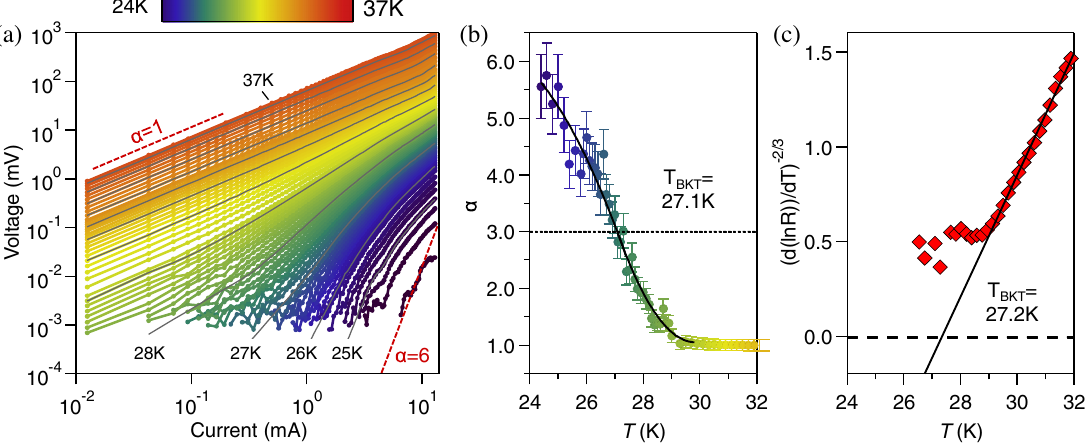
FIG. 3. In situ V ð I Þ characteristics and R ð T Þ analysis. (a) Current-voltage characteristics for 1-uc-thick FeSe = SrTiO 3 , shown on log- log scale. Color indicates the temperature for a given V − I curve, where the gray lines indicate temperature spacings of 1 K. Red dashed lines indicate power-law behavior for V ∝ I α . (b) Extracted temperature dependence of α from power-law fits to the data in (a). (c) ½ d ð ln R Þ =dT (cid:4) 2 = 3 plotted versus T . The solid black line indicates behavior consistent with T voltages for V ð I Þ ∝ I α [Fig. 3(b)]. As expected for a BKT-